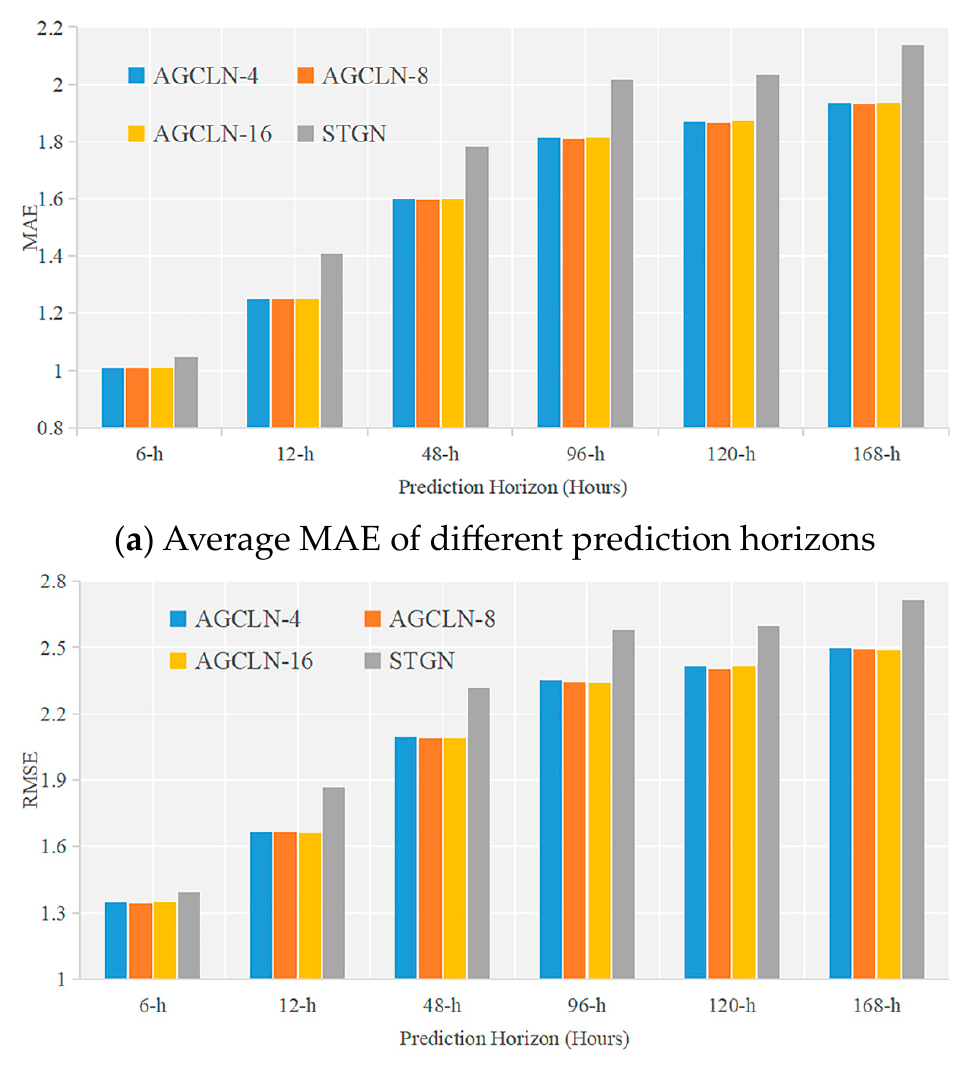
Figure 7. The performance of different channels on 40 nodes. Here, we study the influence of the node-embedding dimension in our network. We find that the model AGLCN achieves good performance in all embedding dimensions. To better demonstrate the correlation between node-embedding dimensions and prediction performance, we counted the variance of different node-embedding dimensions. The result is shown in Figure 8a, where the horizontal coordinates are the prediction scales, the vertical coordinates are the variances, and the size of the circles represents the number of model parameters in different dimensions (the larger the dimension, the larger the number of parameters). The mean values of the RMSE for different node embedding dimensions at different prediction scales (6 h, 12 h, 18 h, 1 d, 2 d, 3 d, 4 d 5 d, 6 d, 7 d) are 1.345, 1.523, 1.660, 1.774, 2.090, 2.251, 2.334, 2.411, 2.456, 2.500 m/s. We can observe that our model also maintains a strong robustness in the node-embedding dimension, i.e., the node embedding expresses little correlation with the prediction performance (the variance random). Altogether, we set the node-embedding dimension to